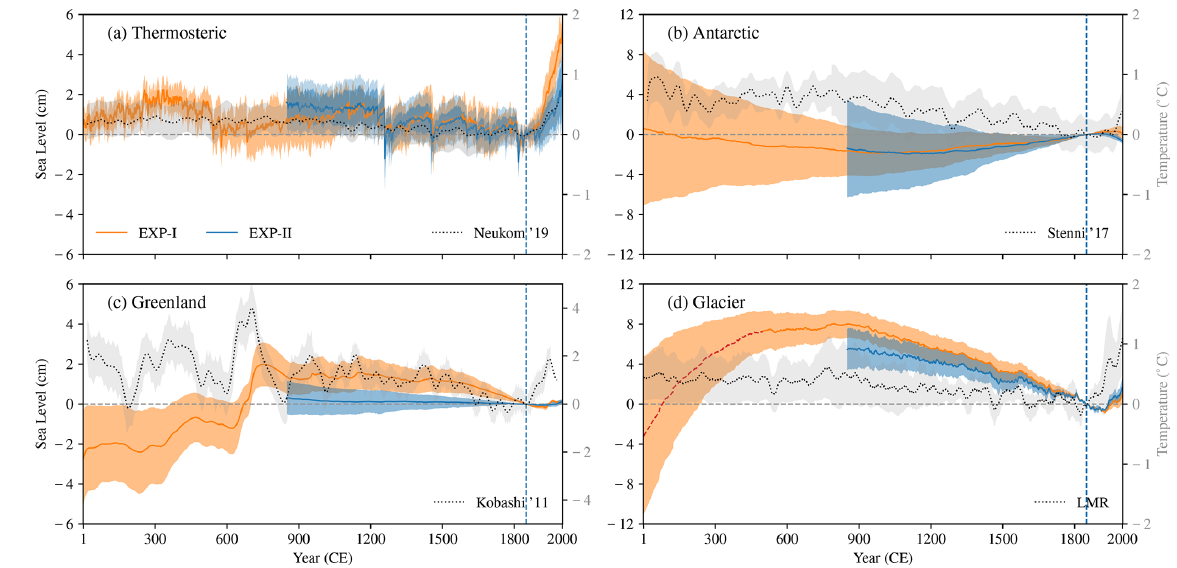
Figure 2. Contributing components to GMSL. (a) Thermosteric, (b) Antarctic ice sheet mass changes, (c) Greenland ice sheet mass changes, and (d) glacier mass changes. Orange (EXP-I) and blue (EXP-II) curves represent the two sets of model simulations used in this study (see Table 1). Global-mean surface temperature from Neukom et al. (2019a) (a) , surface temperature over Antarctica ( b ; from Stenni et al., 2017), Greenland ( c ; from Kobashi et al., 2011) and the glacier-area weighted surface temperature over 18 glaciated regions listed in the RGI ( d ; from LMR) are shown as dotted grey lines. The shading around sea-level curves, Greenland and glacier surface temperatures indicates 1 σ confidence level of the mean, and the shading of global-mean surface temperatures (Antarctic surface temperature) show the 95% confidence levels (2RMSE). Light blue shading of EXP-II thermosteric sea level (a) indicates the additional source of uncertainty arising from temperature changes below 700m (see text and Fig. 1). The glacier contribution during 1–500 CE (EXP-I) is shown with a red-dotted line to indicate the uncertainty related to model initialization and spin-up (see Sect. 2.3). All the curves are anomalies to 1841–1860 mean (dashed blue line at 1850